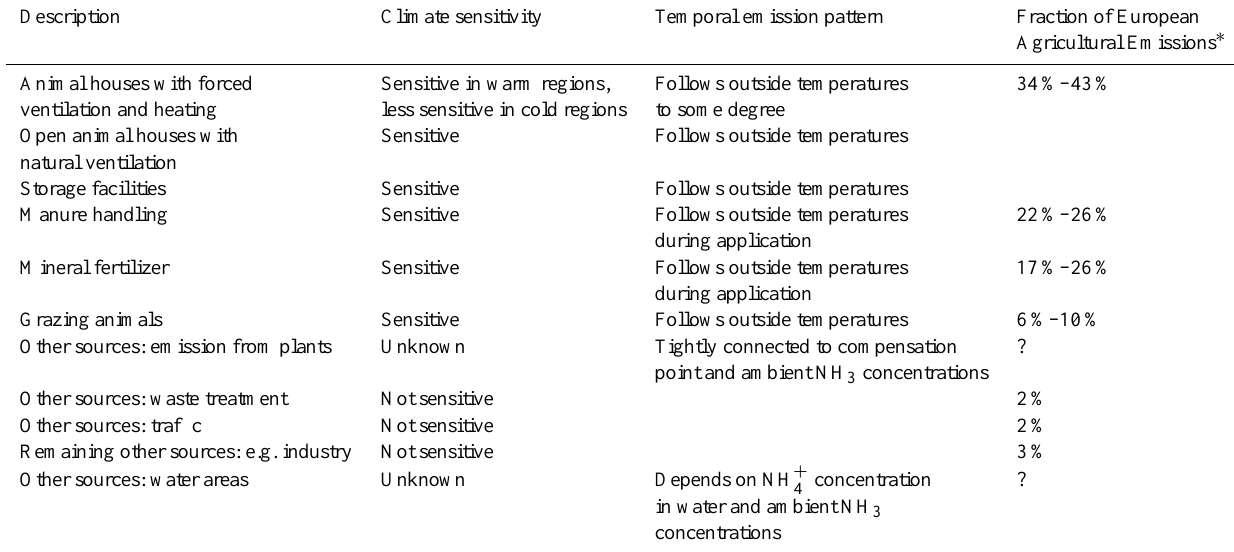
Table 2. The main ammonia emission categories in Europe, an indication of their sensitivity to climatic variables as well as an overview of the contribution to the total emission from agricultural sources in